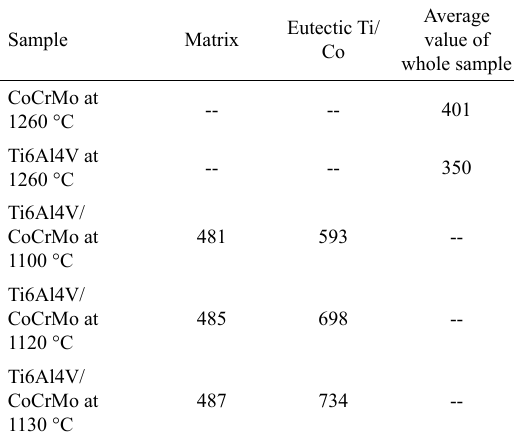
Table 1. Microhardness values of composites sintered at different temperatures. Reference values of samples of Ti6Al4V and CoCrMo sintered at 1260 °C are